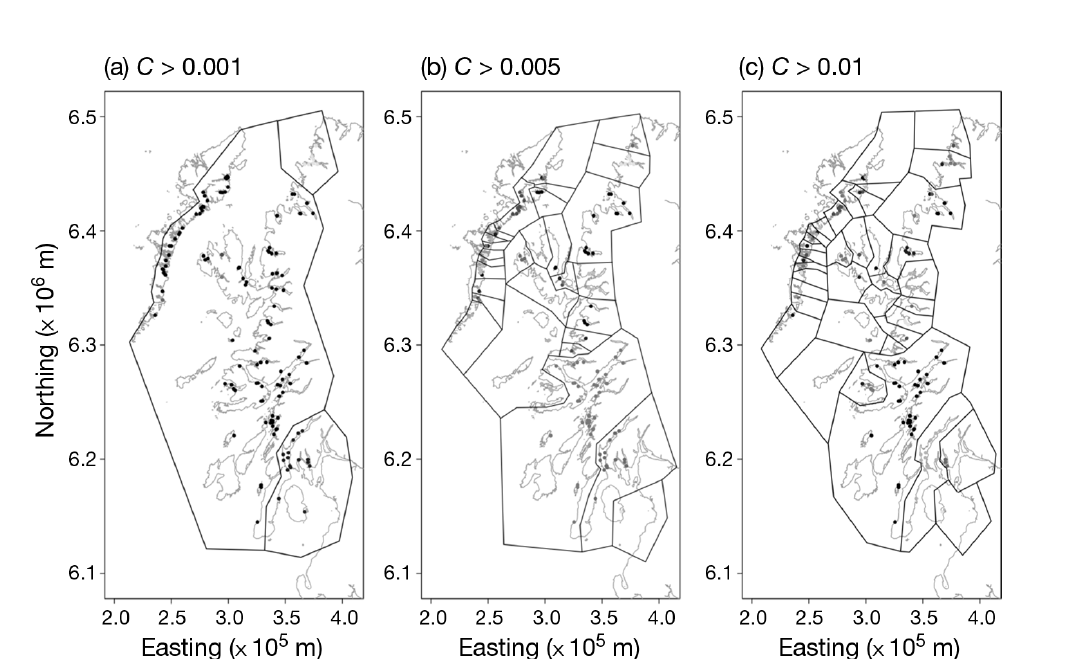
Fig. 6. ‘Weak’ active site clusters (sites linked by connections either to or from one another) created by including only mean connections greater than a range of thresholds. (a) C ij > 0.001. (b) C ij > 0.005. (c) C ij > 0.01. In each panel, recommendations for unit boundaries based upon the chosen threshold are